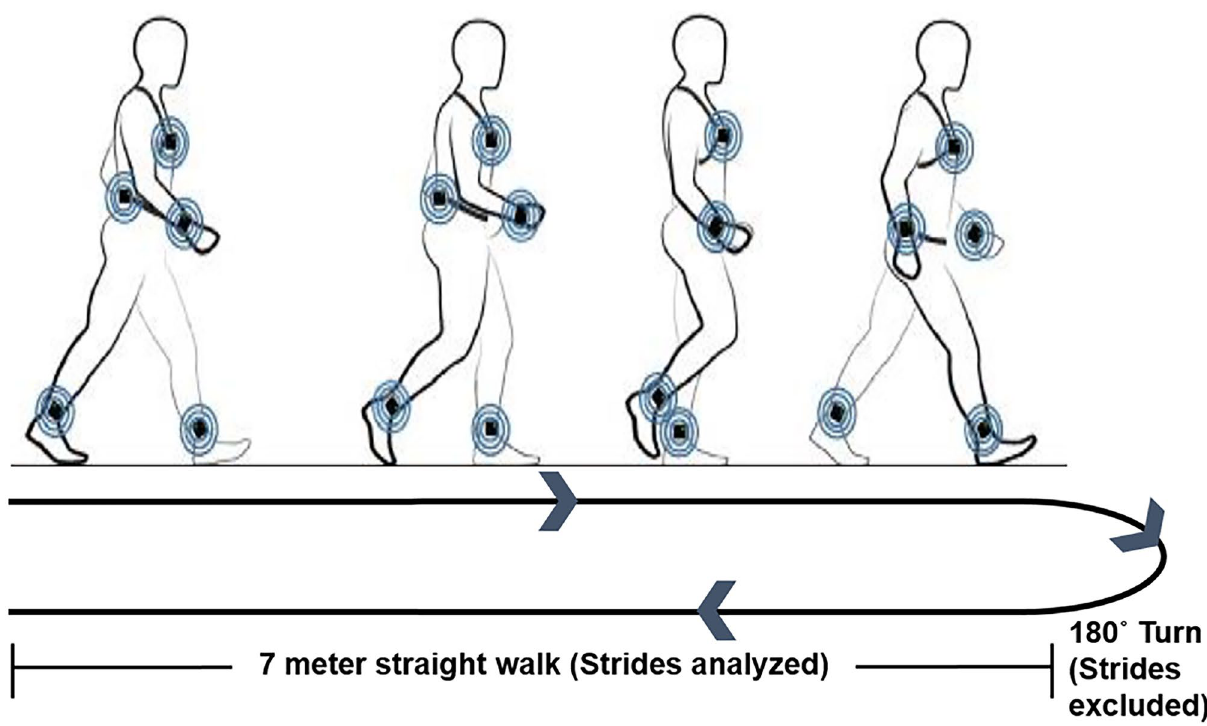
Figure 5. Schematic of the walking task: Participants walked straight for 7 m then turned 180° and walked back straight 7 m. Consecutive strides from the straight portion of the walking trial were used to compute the gait variables and the strides involved in turning were excluded from the gait